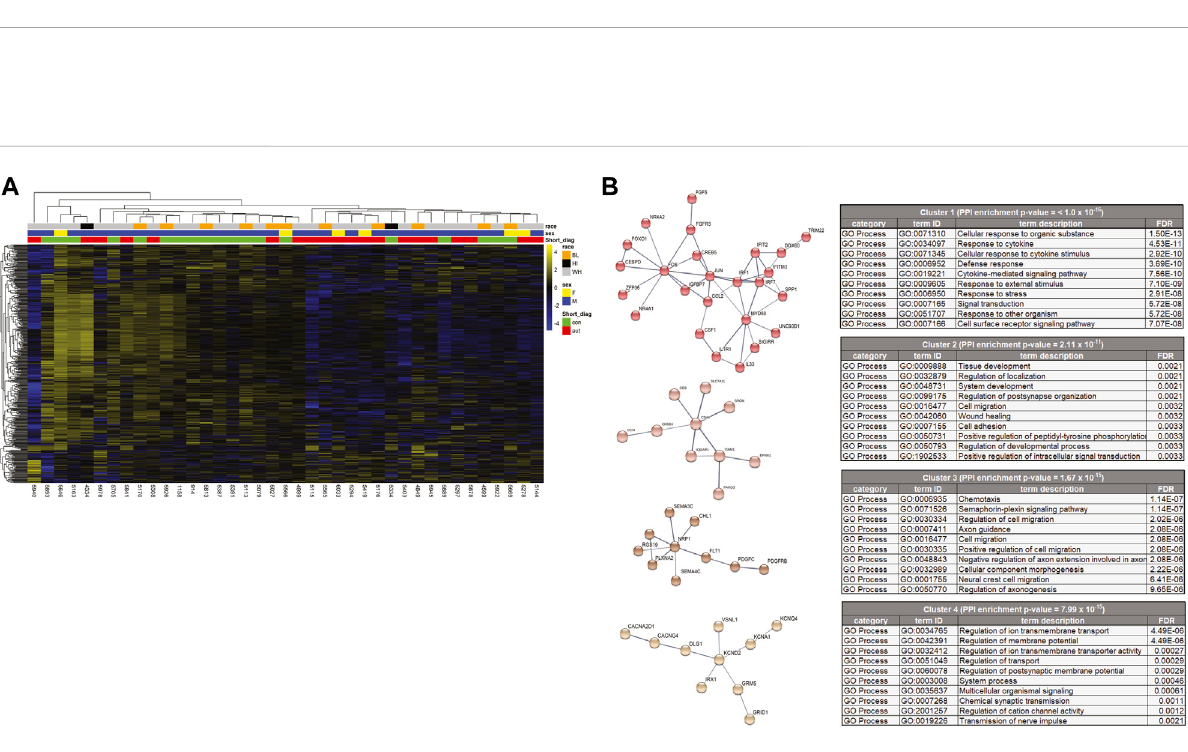
FIGURE 1 Lasercapturemicrodissection anddifferentialexpression analysis. Tissueis stainedwith arapidNissl protocol, whichclearlydelineatesPurkinje cells basedon theconsistent architectureofthecerebellarcortex andlarge cell bodies (A) . The ZeissRoboPalm software isused tomanuallyoutline individual thinly sliced (8 µm) Purkinje cells (B) and speci fi cally removes the cell body, leaving the other cells and tissue behind (C) . After RNA extraction and sequencing, Principle Linear regression models within DESeq2 were used to test differentially expressed genes between individuals with ASD and controls, correcting for covariates of age, self-reported ethnicity, sex, and post-mortem interval (D) . The top ten signi fi cant up- and down-regulated genes are provided (E) .